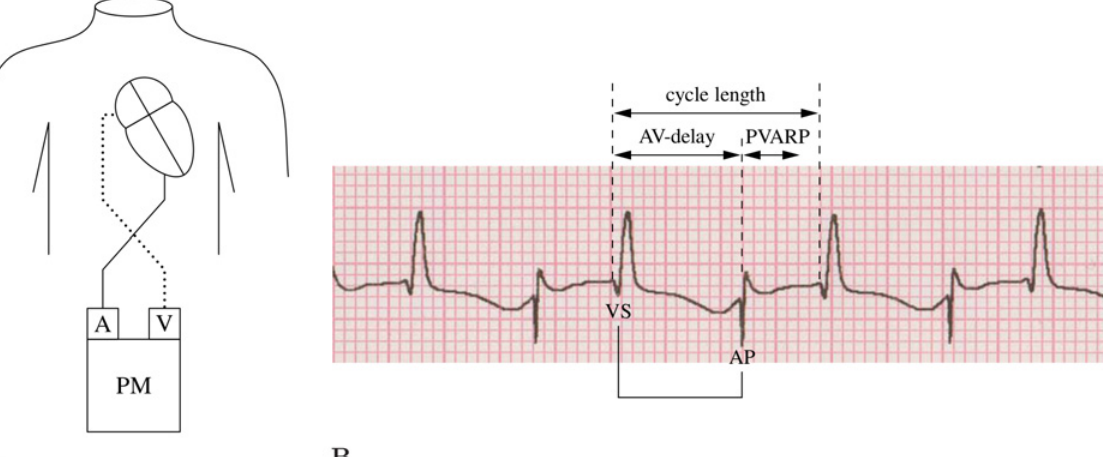
Fig 1. Principles of AVT pacing. (A) External pacing wires are switched at the pacemaker´s inputs. The pacemaker senses ventricular depolarization via the atrial channel and stimulates the atria before the next QRS complex, modified from [6]. (B) Original electrocardiogram during AVT pacing in a 3-month-old child with postoperative JET. A: atrial input, V: ventricular input, PM: external pacemaker, VS: ventricular sensing, AP: atrial pacing, AV: atrioventricular, PVARP: postventricular atrial refractory period.